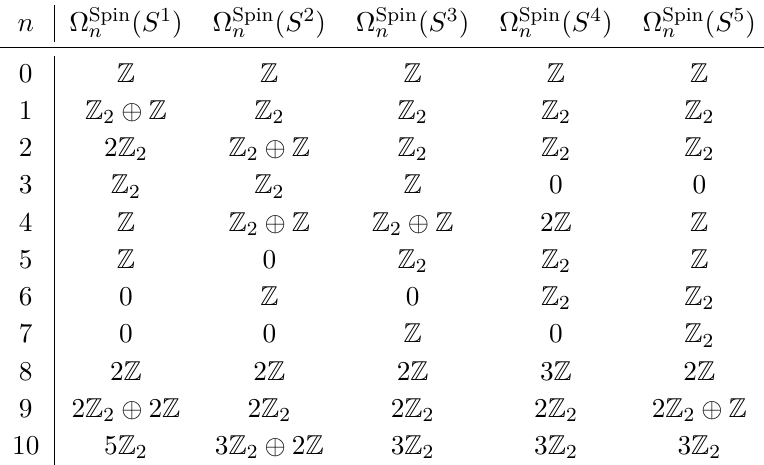
Table 20 . Spin cobordism groups of spheres Ω Spin